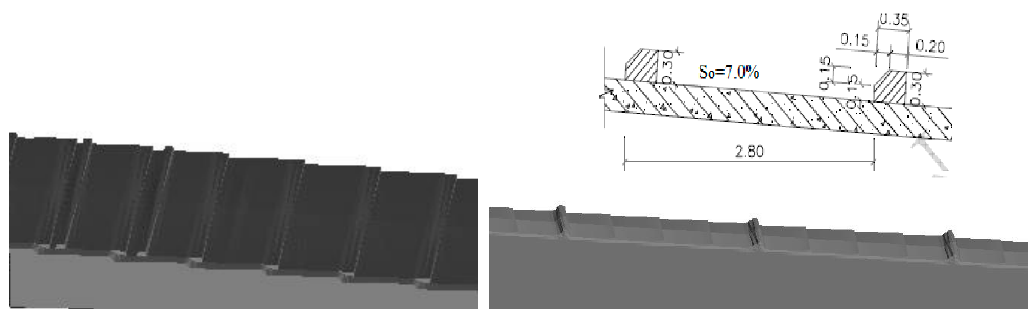
Figure 6. Water elvevation and velocity profiles in the design scenario.